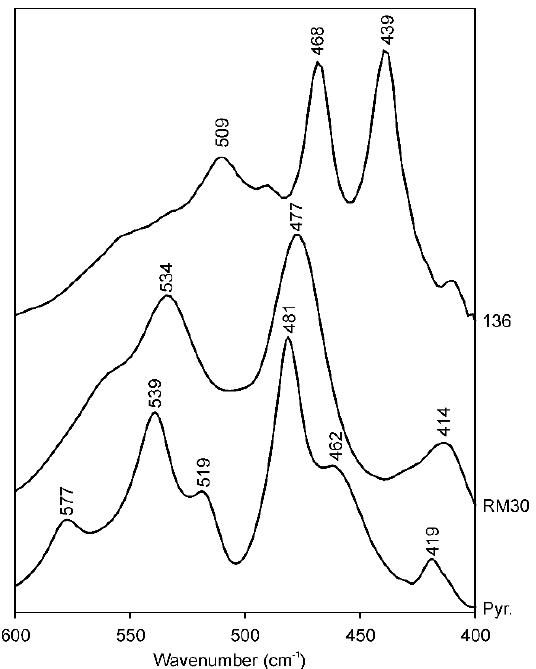
Figure 4. FTIR spectra of ( a ) aluminoceladonite 136, ( b ) illite RM30 and ( c ) pyrophyllite (North Carolina) in the Si–O bending region (600–400 cm − 1 ).